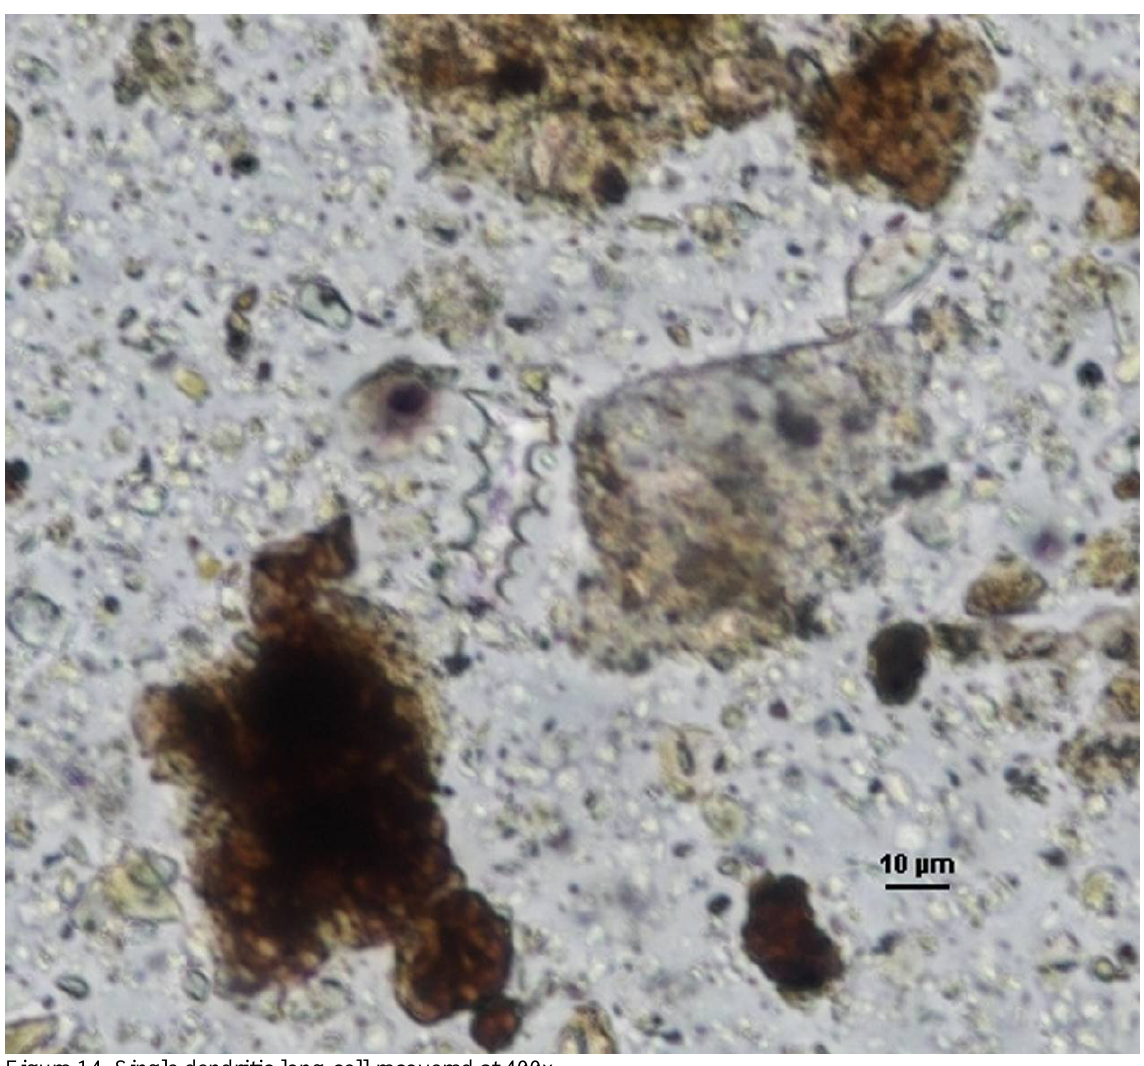
Figure 14. Single dendritic long-cell recovered at